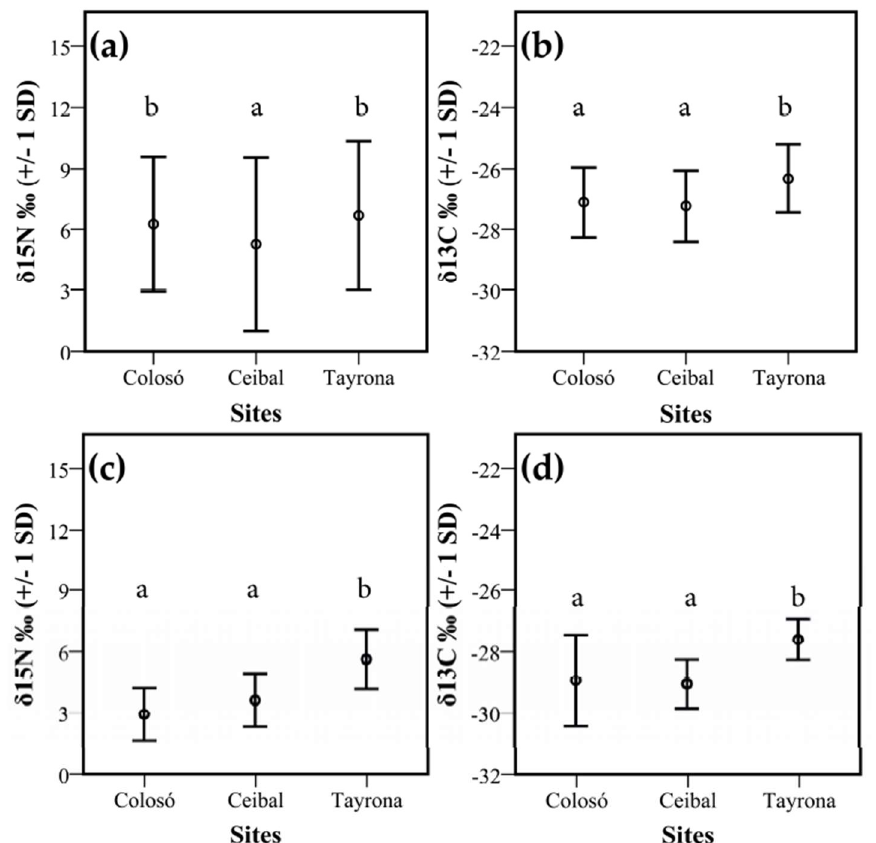
Figure 4. Isotope signatures of δ 15 N and δ 13 C between study sites. Shown are mean values +/− 1 SD for termite ( a ) δ 15 N‰ and ( b ) δ 13 C‰ and litter ( c ) δ 15 N‰ and ( d ) δ 13 C‰ over all three sites: Colosó, Ceibal, and Tayrona. Different letters indicate significant differences between sites (Tukey test, p < 0.05).